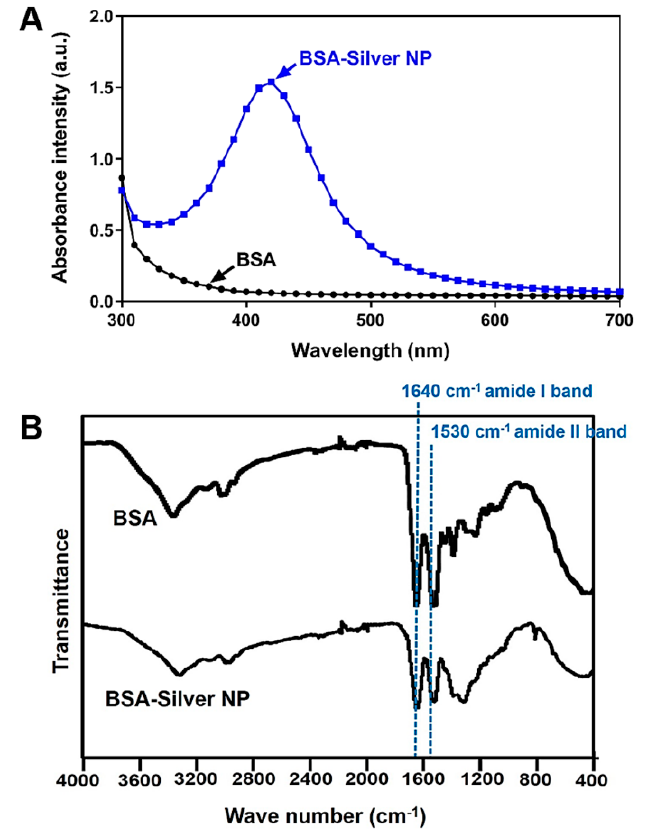
Figure 2. UV/VIS absorption and FT − IR spectra of BSA − Silver NPs: ( A ) UV − VIS absorption spec- trum and ( B ) FT − IR spectrum. The representative surface plasmon resonance peak of silver NPs